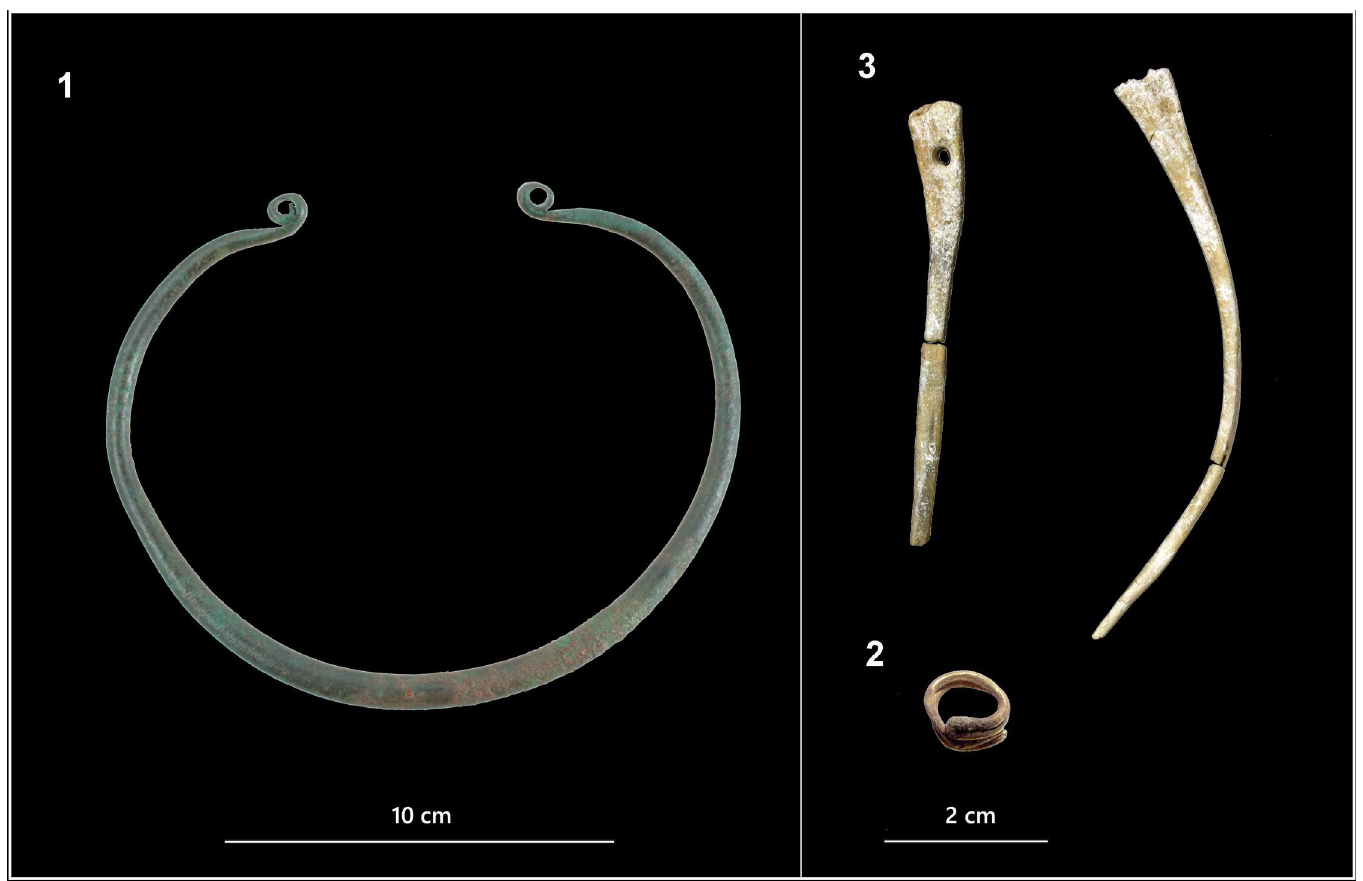
Fig 5. Grave goods from burial n. 241. 1. Bronze neck-ring ( Ösenring ); 2. Gold hair-ring ( Noppenring ); 3. Bone pins/needles ( Knochennadeln ).